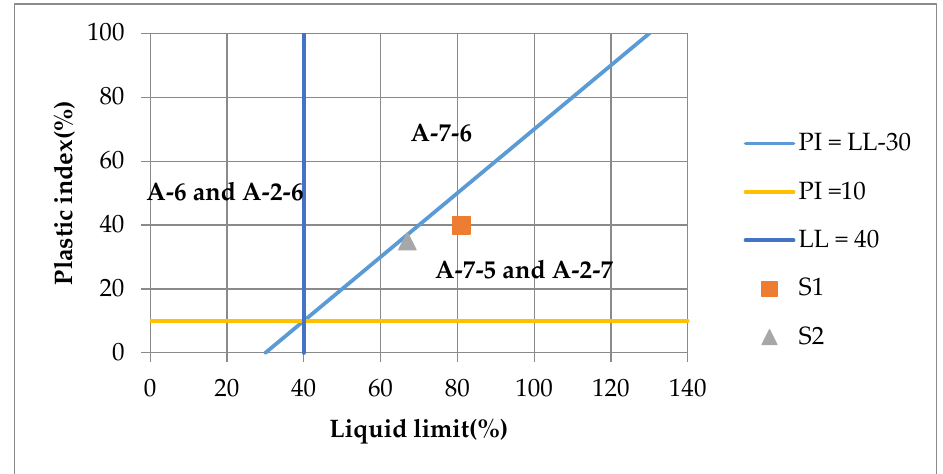
Figure 5. Soil plasticity chart for fine-grained soil according to the AASHTO classification system